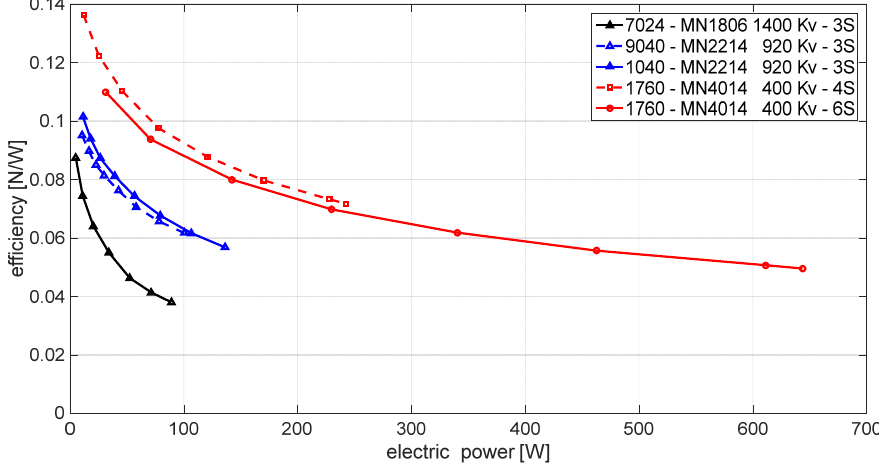
Figure 22. The overall efficiency of selected EPUs.